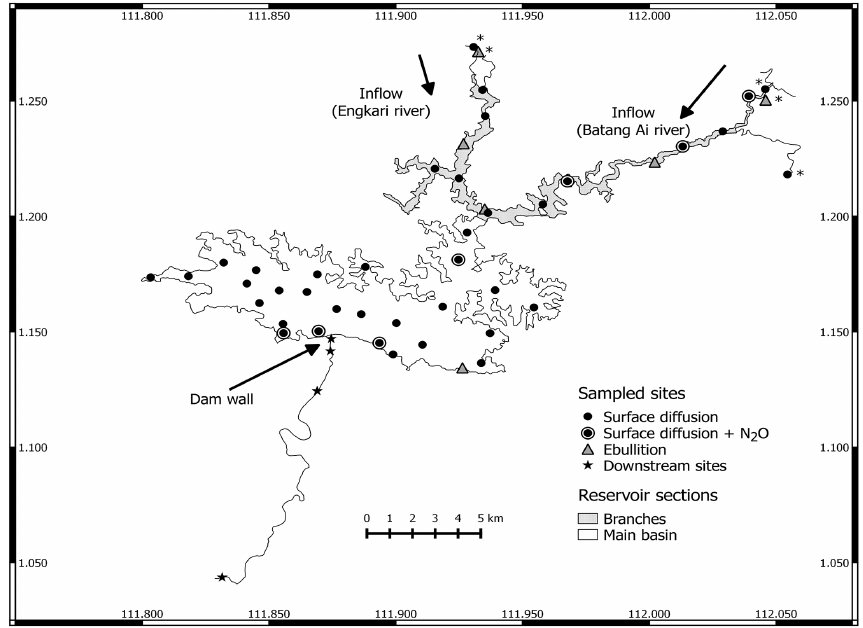
Figure 1. Map of Batang Ai showing the location of sampled sites and reservoir sections. * Represents the reservoir inflow